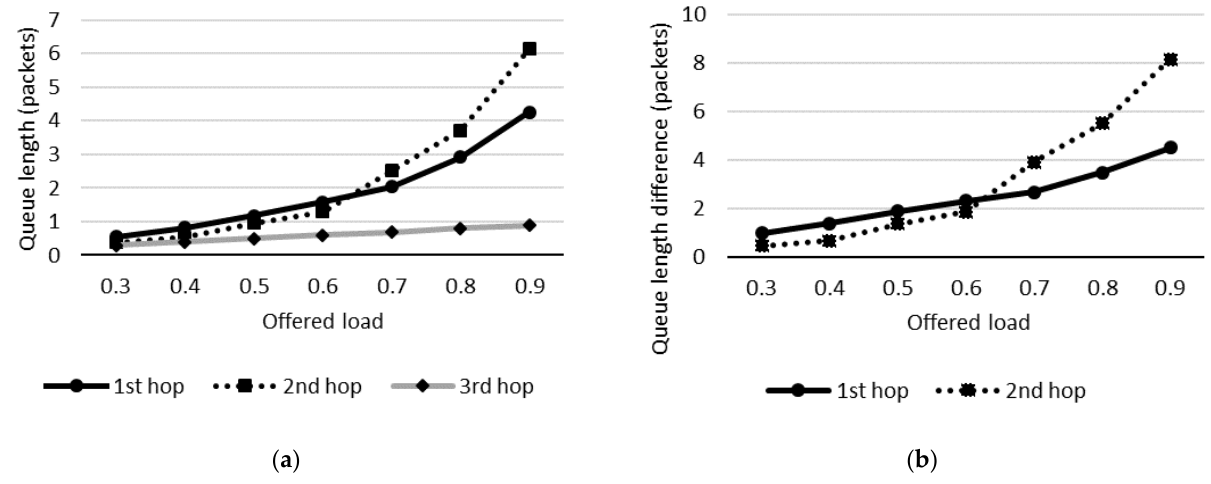
Figure 9. ( a ) Average queue lengths; and ( b ) difference between the queue lengths of link groups.